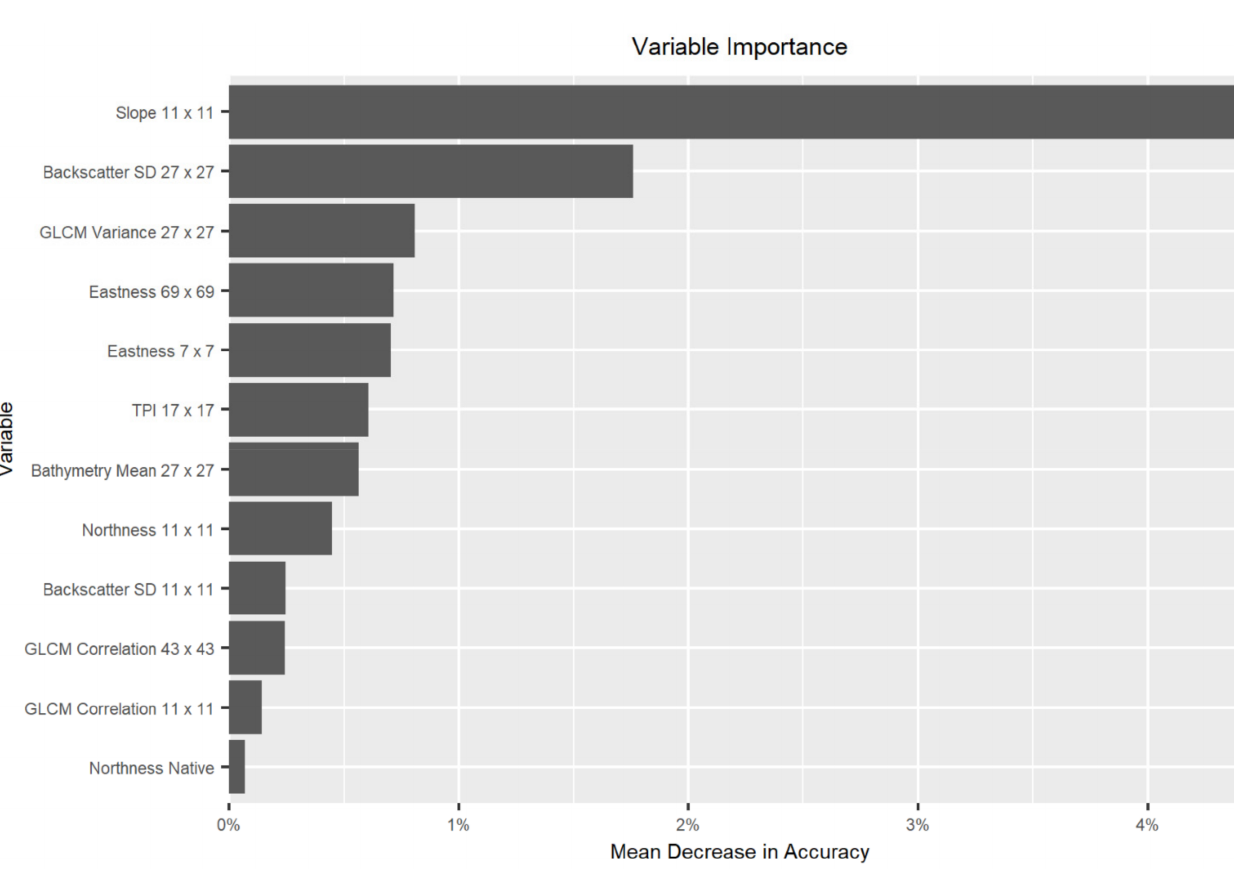
Figure 7. Permutation variable importance of the MBES derived predictor variables in determining substrate type for the supervised (random forest) classification model in the Elbow of the west Florida shelf. The reported values of mean decrease in accuracy are unscaled (not divided by standard deviation) as suggested in Strobl and Zeileis